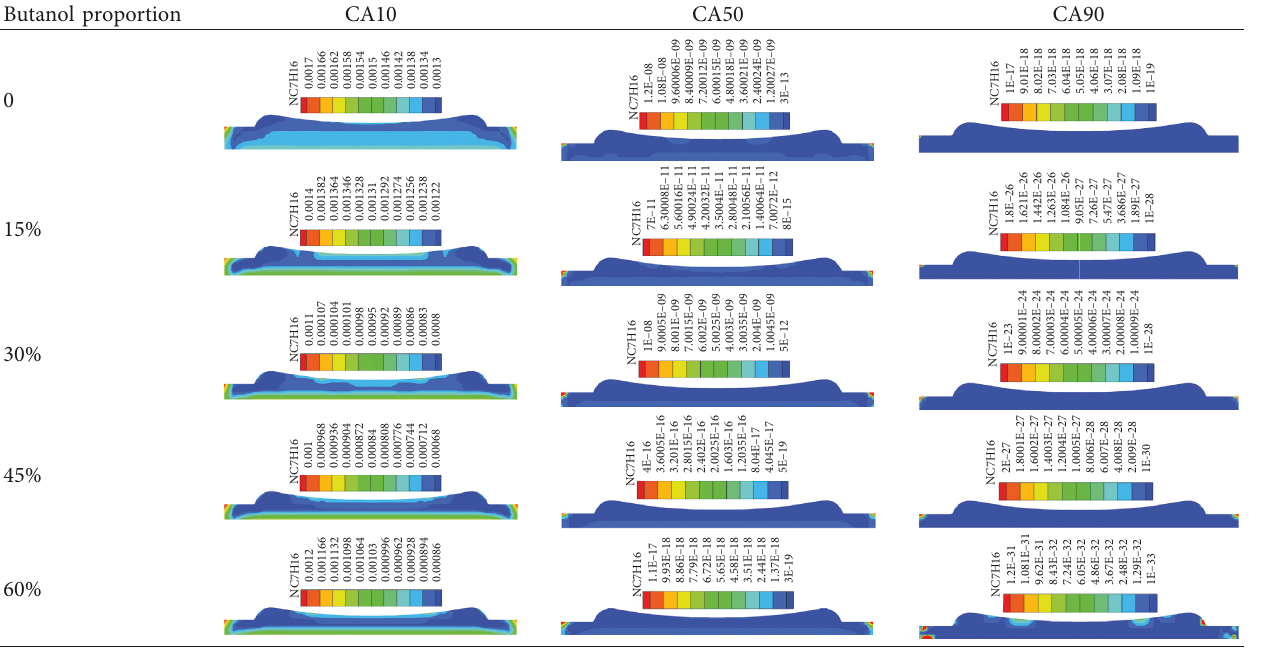
Table 2: The in-cylinder distribution of C7H16 concentration.